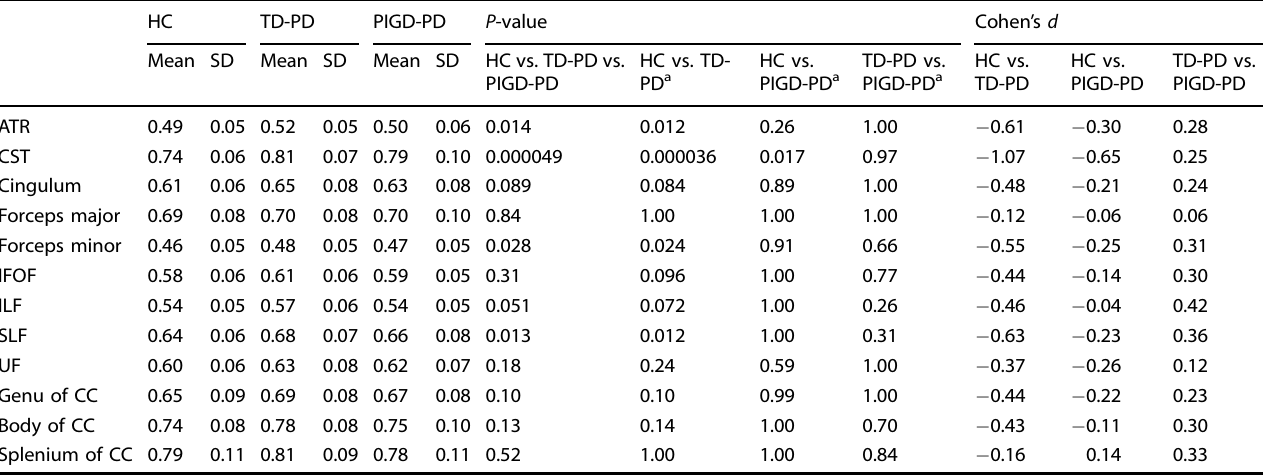
Table 2. Fiber density and cross section values of white matter tracts.